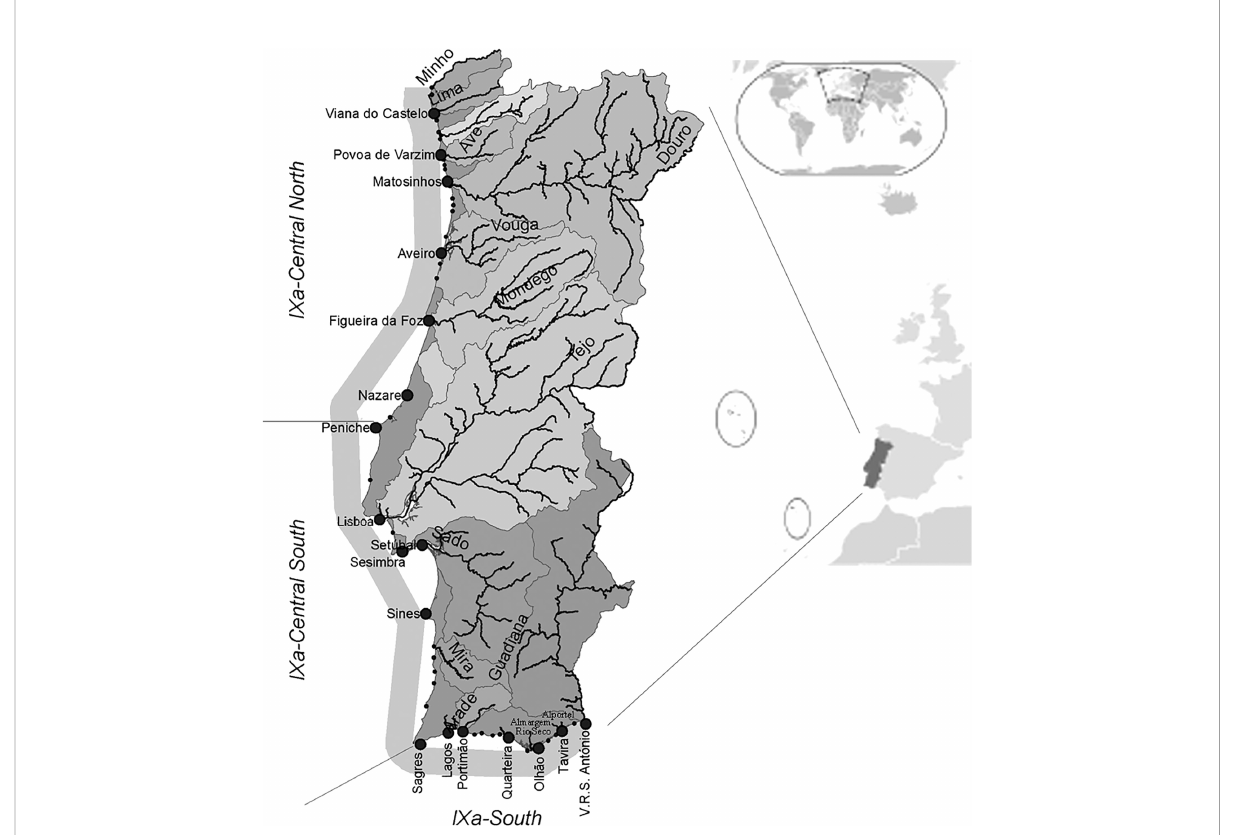
FIGURE 1 Location of the main fi shing ports and freshwater inputs of Portuguese coast divided according to the ICES (International Council of the Exploration of the Sea) subdivisions: Northwest (IXaCN- Central North), Southwest (IXaCS- Central South) and South (IXaS-